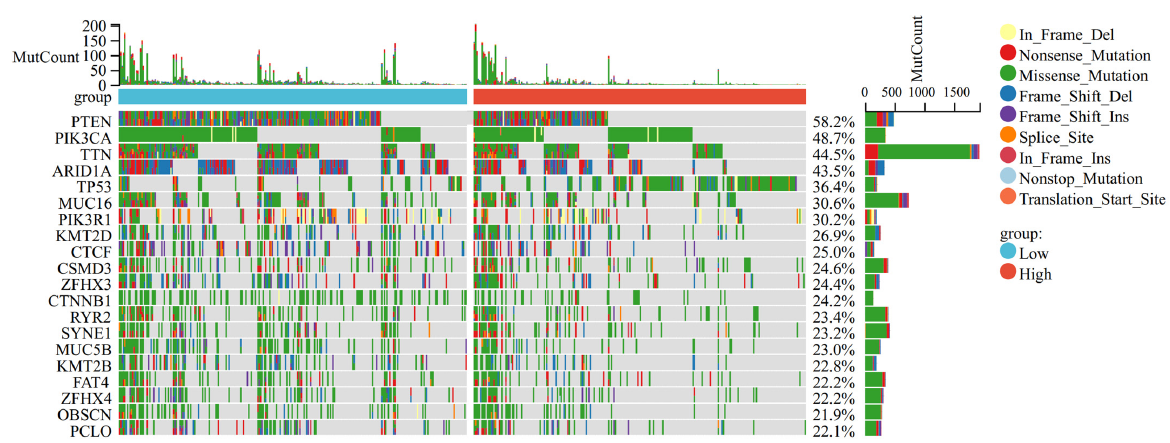
Figure 6. Comparison of somatic mutations between different risk